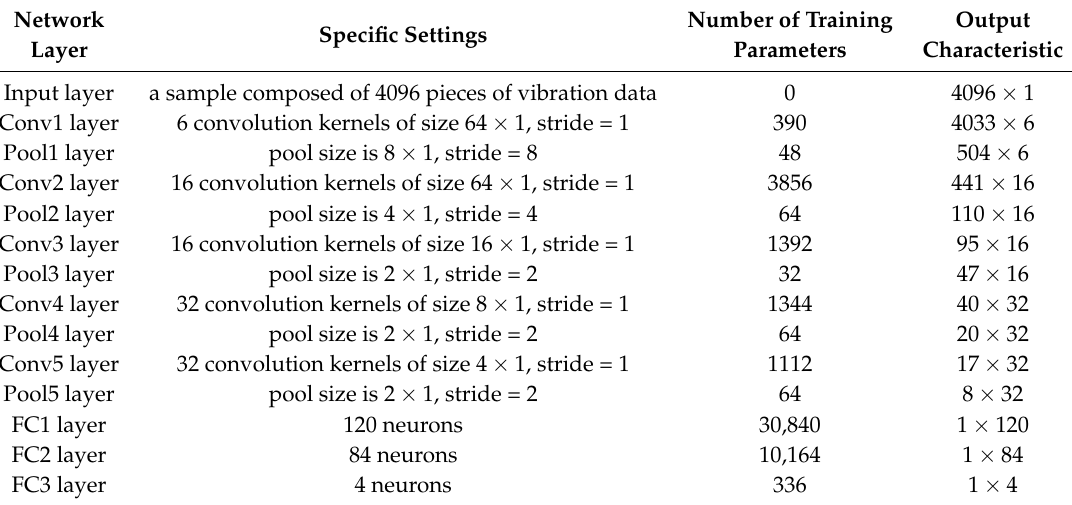
Table 5. Detailed settings of improved 1D LeNet-5 network